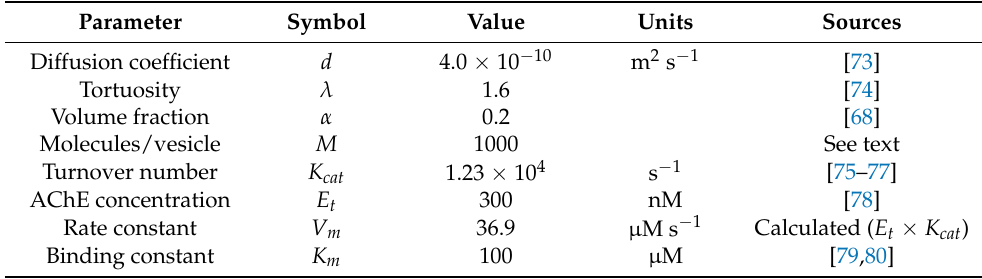
Table 1. Parameter